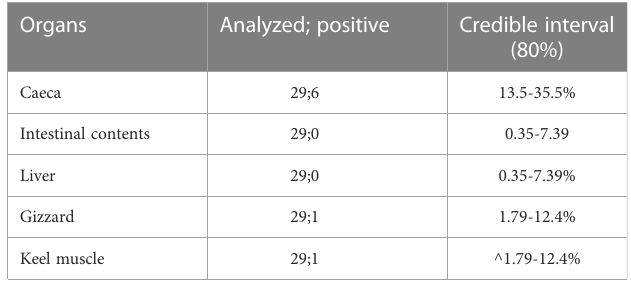
TABLE 3 Credible interval (80%) on prevalence obtained for each analyzed organ of hunted birds in October 2018 at Grand Birieux (site A).